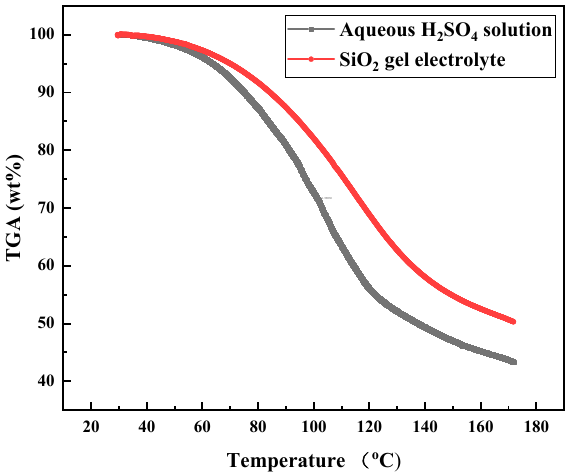
Figure 6. TGA curves of the SiO 2 gel and aqueous H 2 SO 4 solution electrolytes.